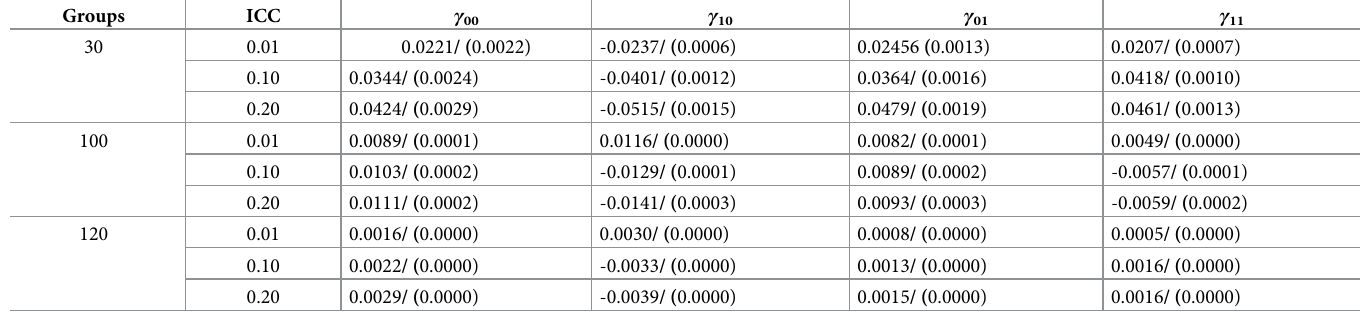
Table 7. Average relative parameter bias of fixed effect estimates obtained for exponential distribution data (First = REML estimation procedure, Second = Bootstrap estimates are enclosed in parenthesis). Groups